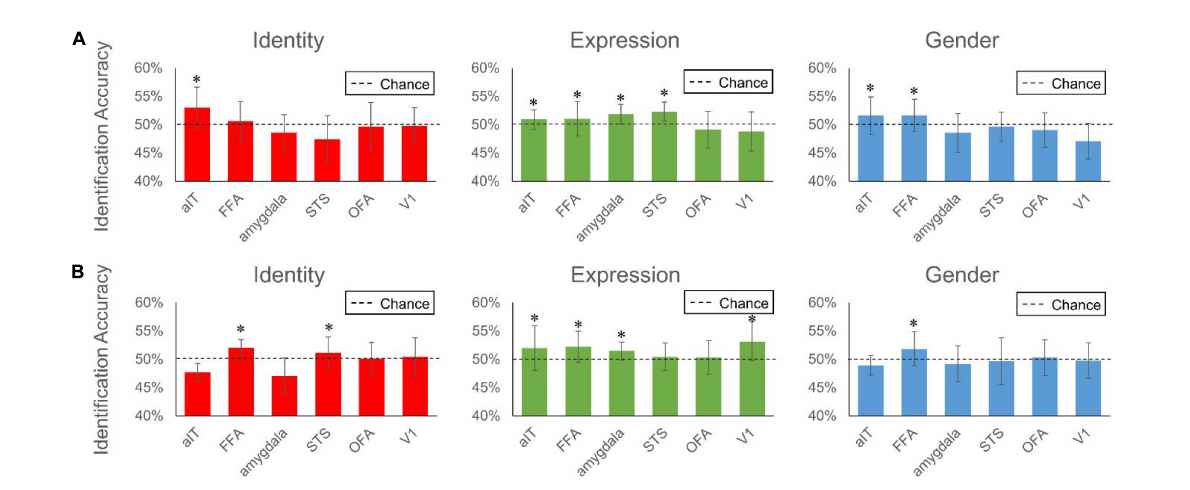
FIGURE7 Reconstruction accuracy of each brain region of interest to facial expression, identity and gender. The two subplots represent performance from brain signals of Subject 1 (A) and Subject 2 (B) , respectively. Bars represent group-average accuracy ( ± SEM across 40 pairs). Black dashed line indicates the chance level reconstruction accuracy of 50%. *Indicates group-level significance p <